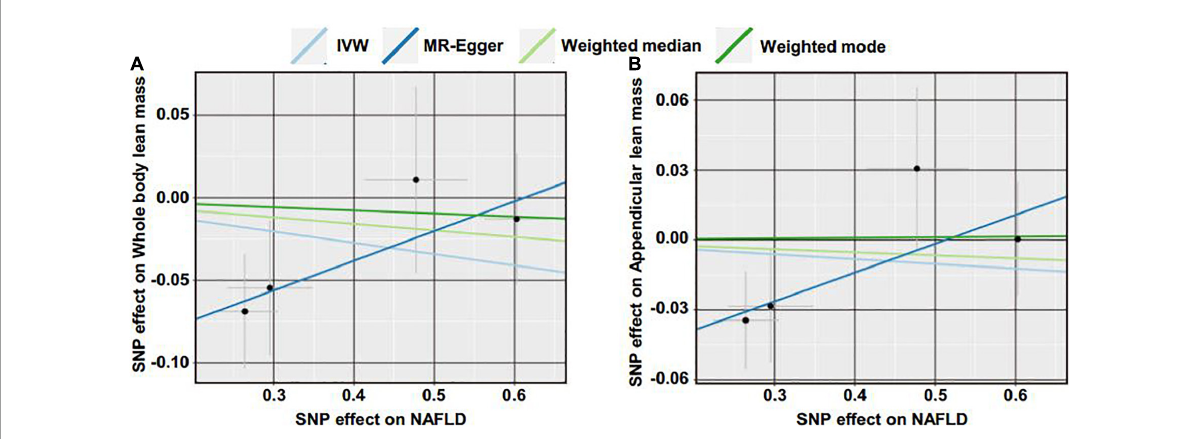
FIGURE4 Scatter plot of the causal effect of NAFLD on lean body mass using different MR methods. (A) Causal effect of NAFLD on whole body lean mass. (B) Causal effect of NAFLD on appendicular lean mass.